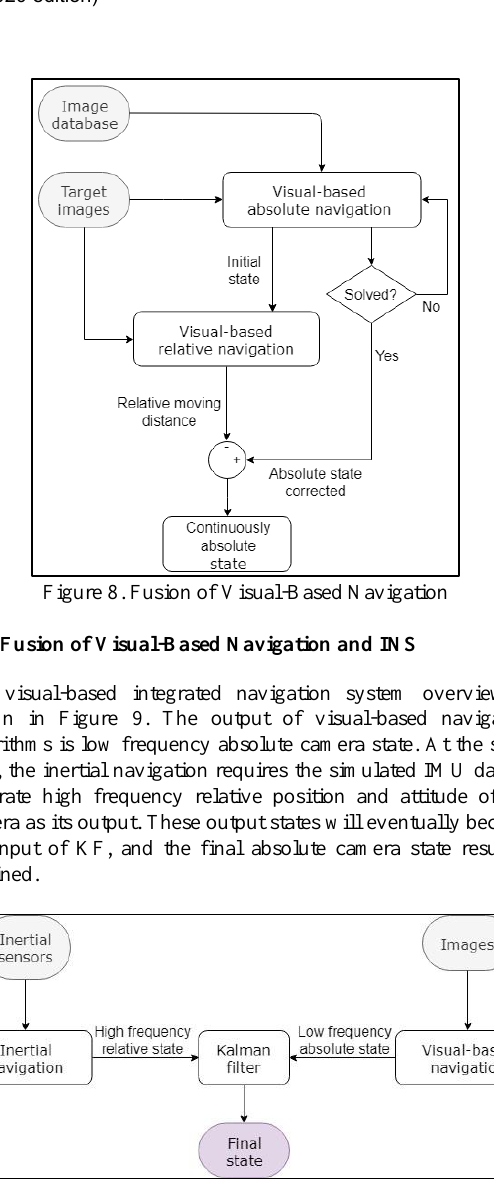
Figure 9. Fusion of Visual-Based Navigation and